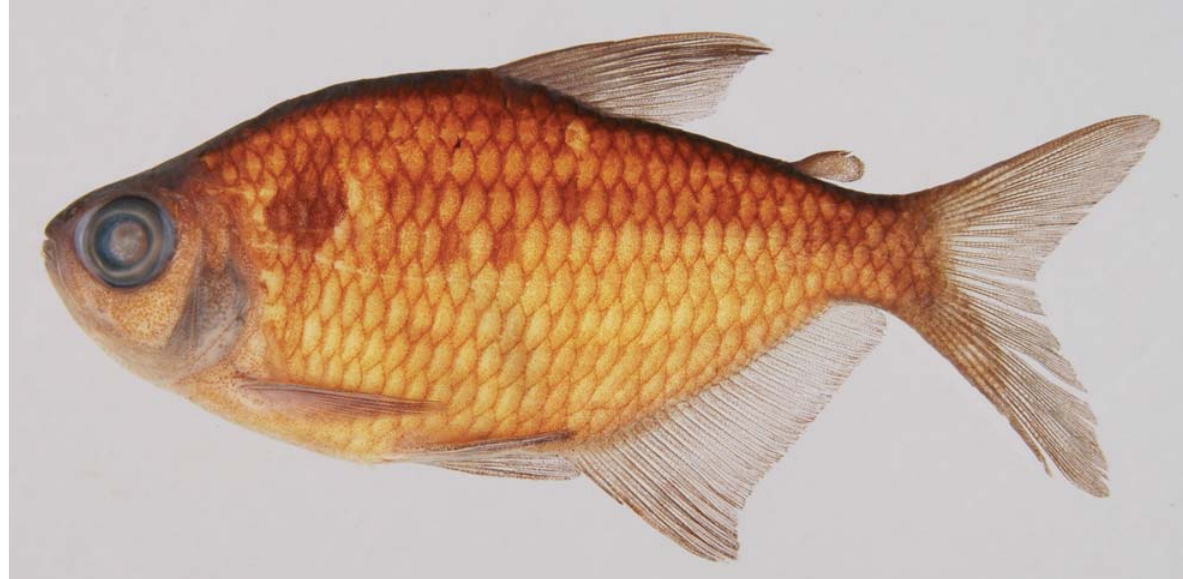
Fig. 1. Moenkhauasia diamantina , MNRJ 30168, holotype, 48.5 mm